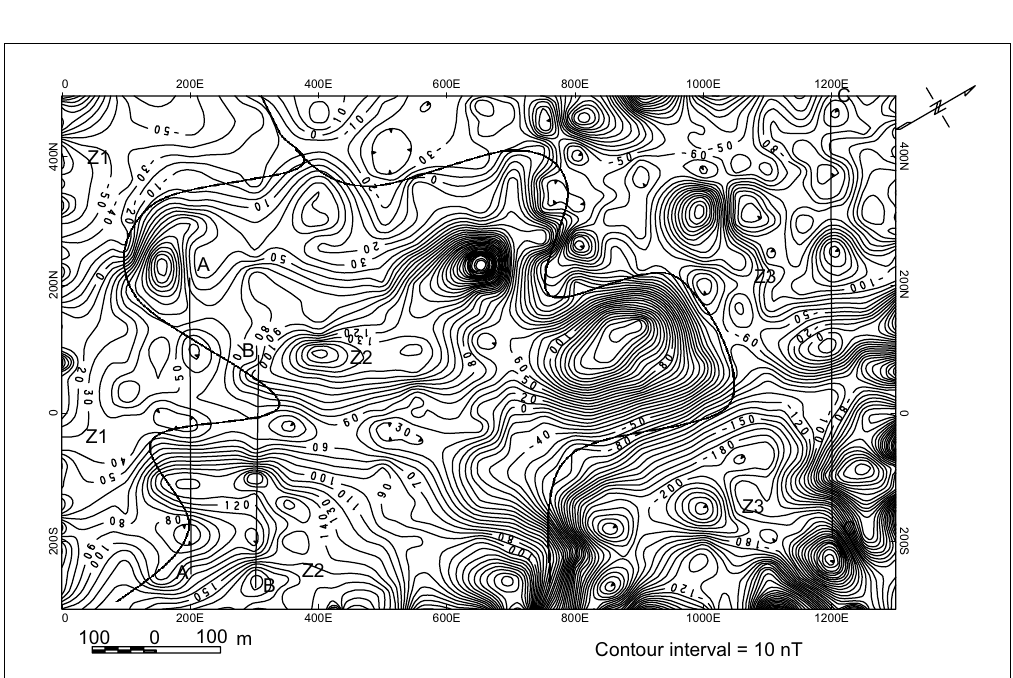
Fig. 3. Total intensity magnetic map of the Abu-Shihat radioactive prospect area, North Eastern Desert,